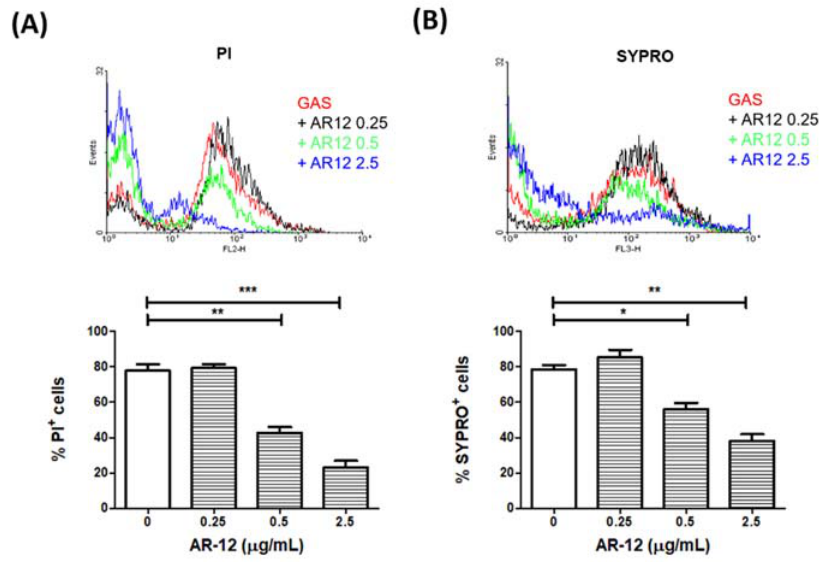
Figure 2. AR-12 reduced the nucleic acid and protein contents of group A Streptococcus . The M49-type GAS NZ131 strain was cultured with different concentrations of AR-12 for 2 h. The total protein and nucleic acid content of GAS were stained with propidium iodide dye ( A ) and SYPRO dye ( B ), respectively, and then analyzed by flow cytometer. The result was determined by the mean fluorescence intensity (MFI) of each group. The percentages of PI + or SYPRO + cells were calculated and expressed as the mean ± standard deviation. Treatment groups were compared for significance using ANOVA. * p < 0.05, ** p < 0.01, *** p < 0.001 compared with the relative groups as shown in the figure.